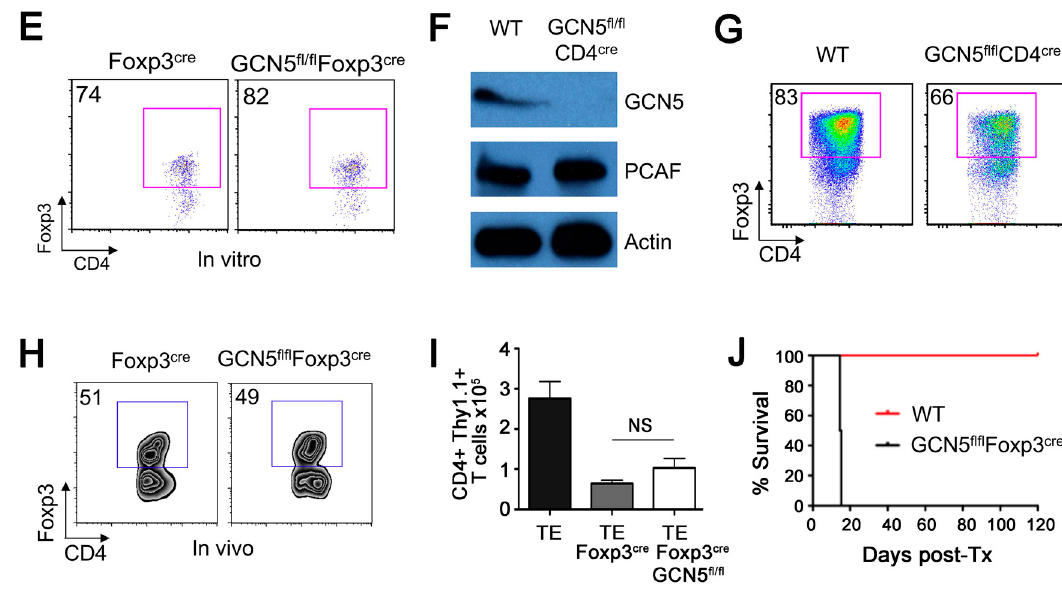
Figure 1. Minor effects of general control nonrepressed-protein 5 (GCN5) deletion on T-regulatory cells (Tregs) in vitro but inhibitory effects on Treg function in vivo. ( A ) Percentages of CD4+ and CD8+ T cell population in peripheral lymph node and spleens of Foxp3 YFP-cre and Foxp3 YFPcre GCN5 flfl mice. ( B ) Comparison of percentages of CD4+CD25+, CD4+CD69+ cells in peripheral lymph nodes and spleens of Foxp3 YFPcre and Foxp3 YFPcre GCN5 flfl mice. ( C ) Comparison of percentages of CD4+Foxp3+ Tregs in lymph nodes, mesenteric lymph nodes, and spleens of Foxp3 YFPcre and Foxp3 YFPcre GCN5 flfl mice. ( D ) CD4+YFP+ Tregs were sorted from Foxp3 YFPcre and Foxp3 YFPcre GCN5 flfl mice, incubated with Pacific Blue Cell-Tracer labeled Foxp3 cre CD4+YFP − T-effector (Teff cells), irradiated APC, and CD3 mAb for 3 days. The percentage of proliferating Teff cells is shown in each panel. ( E ) CD4+yellow fluorescent protein (YFP)+ cells (1 × 10 5 ) were sorted from Foxp3 YFPcre or Foxp3 YFPcre GCN5 flfl mice,